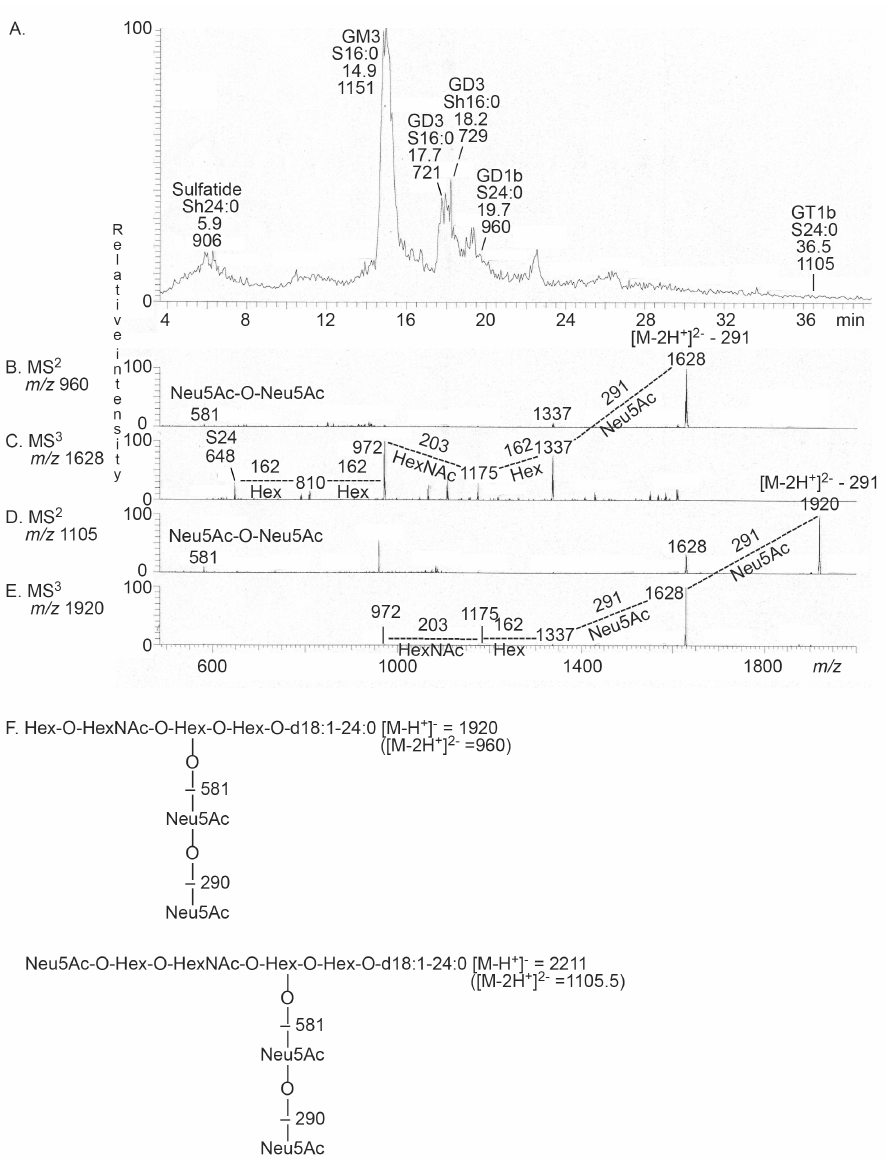
Figure 7. LC-ESI/MS of the total acid glycosphingolipid fraction from human thyroid gland. ( A ) Base peak chromatogram from LC-ESI/MS of the total acid glycosphingolipid fraction from human thyroid gland. ( B ) MS 2 of the ion at m / z 960 (retention time 19.4 min). ( C ) MS 3 of the ion at m / z 1628. ( D ) MS 2 of the ion at m / z 1105 (retention time 36.5 min). ( E ) MS 3 of the ion at m / z 1920. ( F ) Interpretation formula. Sulfatide, SO 3 - 3Gal β 1Cer; GM3, Neu5Ac α 3Gal β 4Glc β 1Cer; GD3, Neu5Ac α 8Neu5Ac α 3Gal β 4Glc β 1Cer; GD1b, Gal β 3GalNAc β 4(Neu5Ac α 8Neu5Ac α 3)Gal β 4Glc β 1Cer; GT1b, Neu5Ac α 3Gal β 3GalNAc β 4(Neu5Ac α 8Neu5Ac α 3)Gal β 4Glc β 1Cer. In the shorthand nomen- clature for fatty acids and bases, the number before the colon refers to the carbon chain length and the number after the colon gives the total number of double bonds in the molecule. Fatty acids with a 2-hydroxy group are denoted by the prefix h before the abbreviation, e.g., h16:0. For the long chain bases, S designates sphingosine (d18:1; 1,3-dihydroxy-2-aminooctadecene) and P phytosphingosine (t18:0; 1,3,4-trihydroxy-2-aminooctadecane). The base peak chromatogram from LC-ESI/MS of fraction P acid-1 from human parathy- roid gland had a molecular ion at m / z 778, indicating sulfatide with d18:1/16:0 (data not shown). MS 2 of this ion identified sulfatide (SO 3 -3Gal β 1Cer) with d18:1/16:0